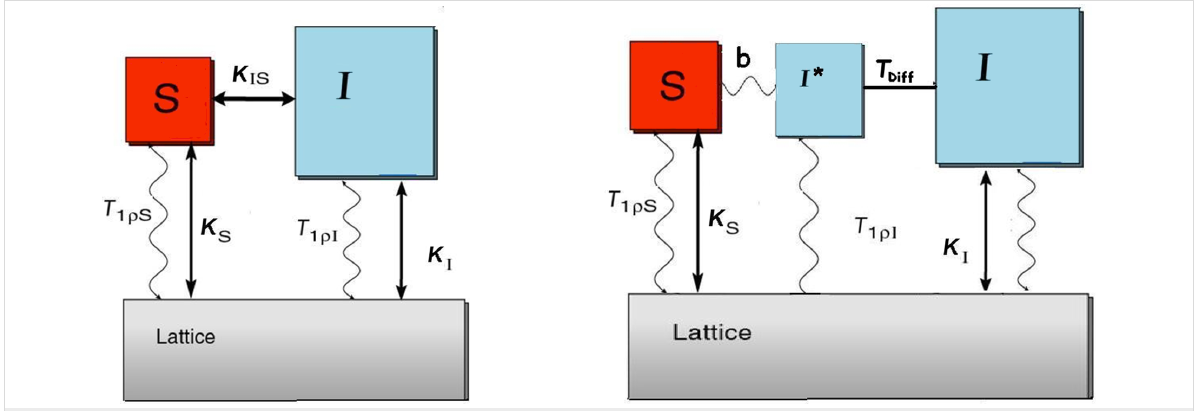
Figure 1: Schematic thermodynamic description of the CP process and time constants. The I-S model (left), the I–I*–S model (right). Adapted with permission from [14]. Copyright 2002 American Chemical Society.